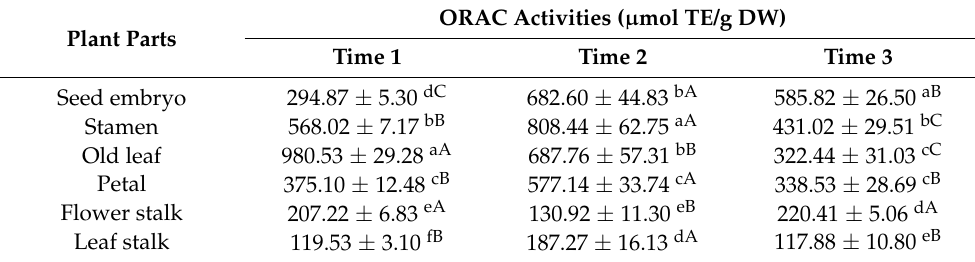
Table 3. Antioxidant activities measured by oxygen radical absorbance capacity (ORAC) assay of different sacred lotus parts collected from different time periods.